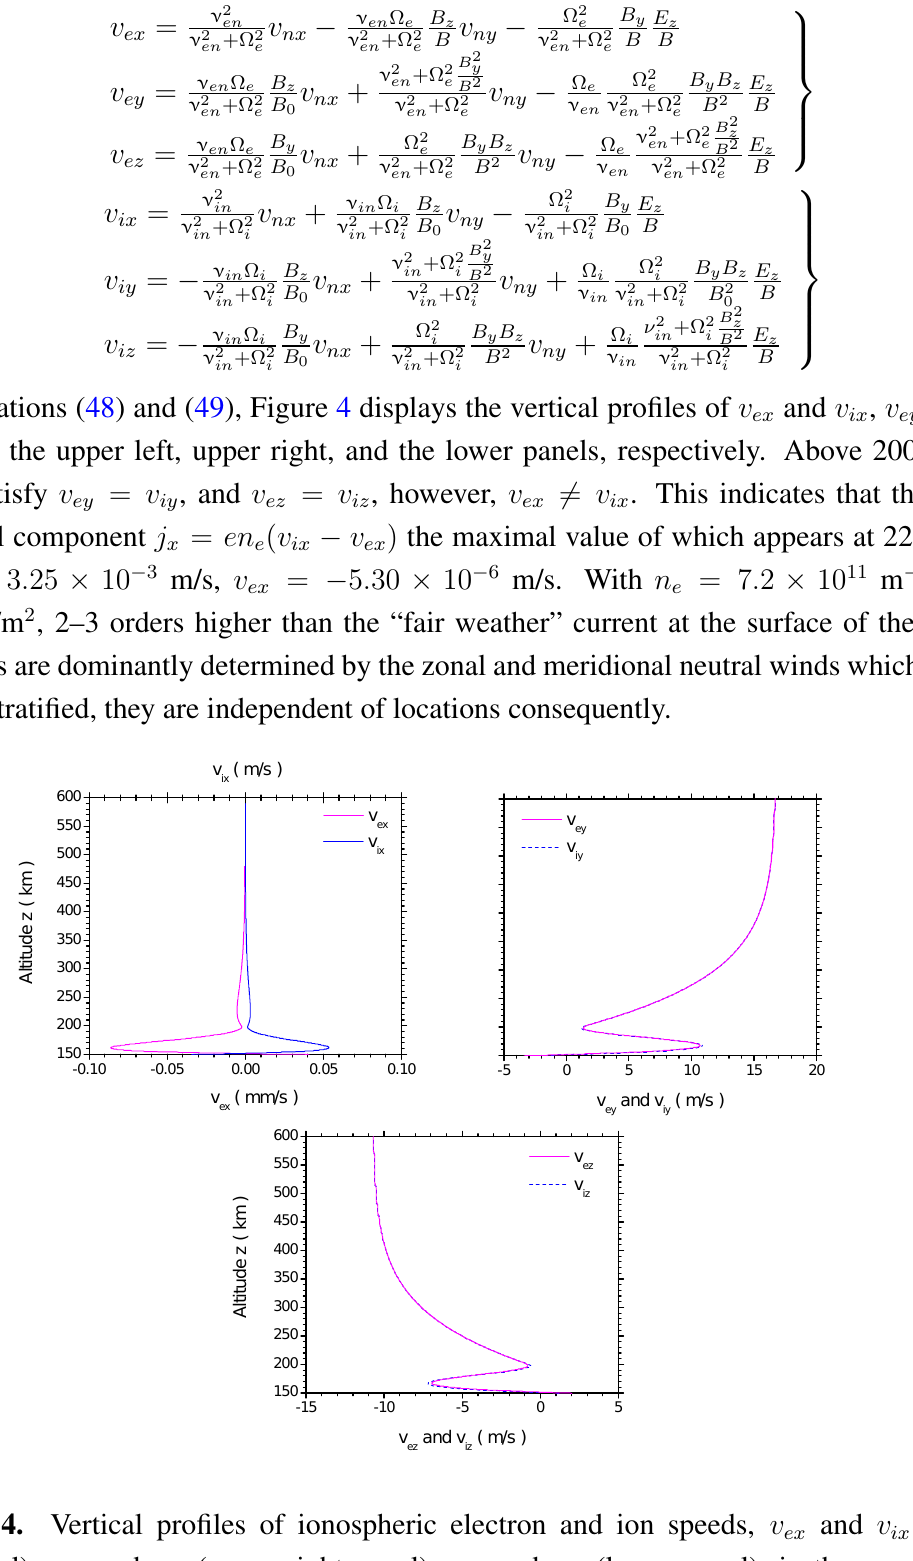
and v (upper ex ix and v (lower panel), in the presence of ez iz